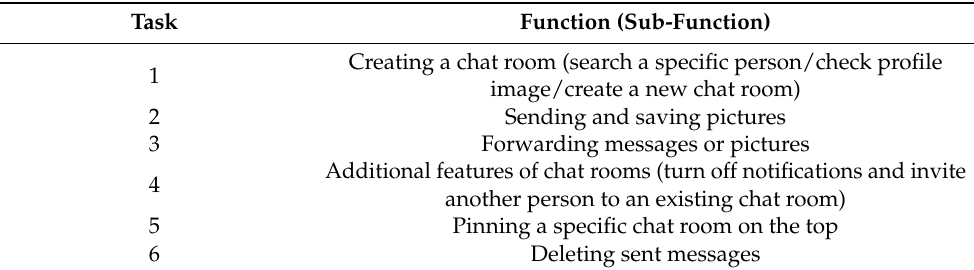
Figure 2. Facial expressions. Table 3. Selected functions and sub-functions of the KakaoTalk app.